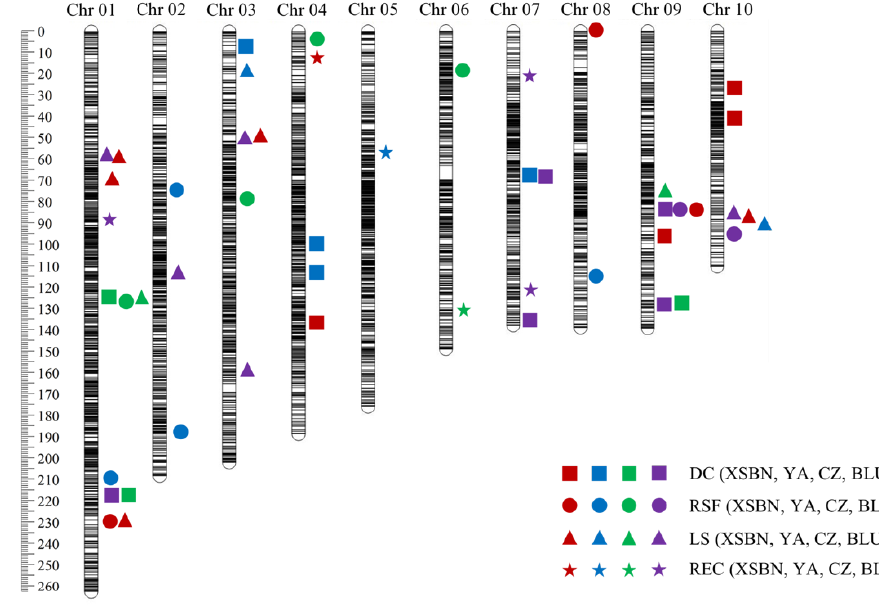
Figure 3. Chromosomal distributions of identified QTLs under three environments in this study. The red, blue, green, and purple represent Xishuangbanna (XSBN), Ya’an (YA), Chongzhou (CZ), and the best linear unbiased prediction (BLUP), respectively. Squares, circles, triangles, and pentagrams represent diameter of callus (DC), rate of shoot formation (RSF), length of shoot (LS), and rate of embryogenic callus induction (REC), respectively. Table 4. QTLs controlling embryogenic callus induction-related traits across three environments.